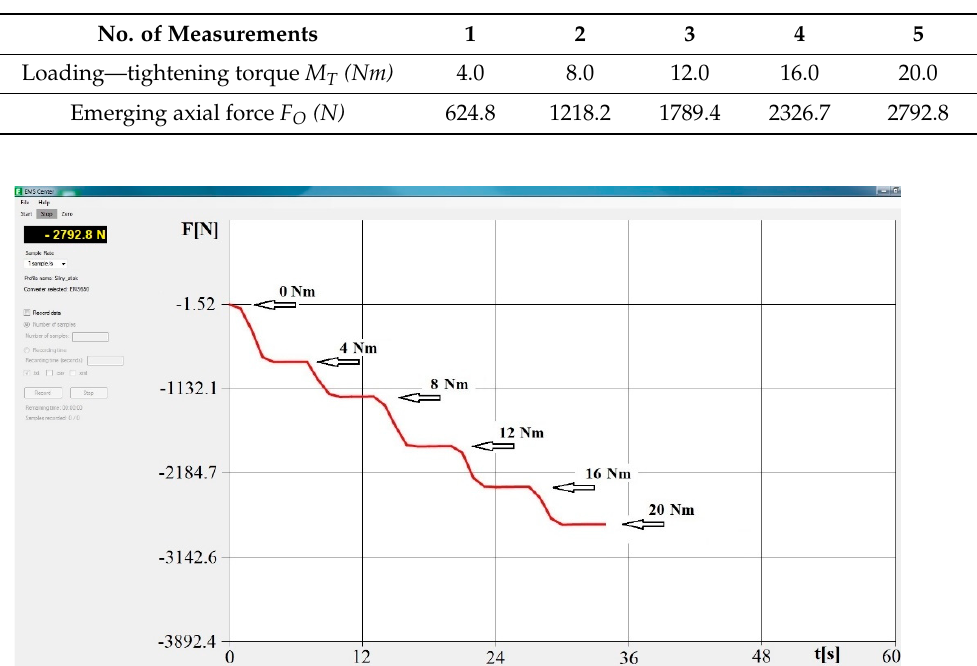
Figure 7. Visual comparison of the used lubricants.